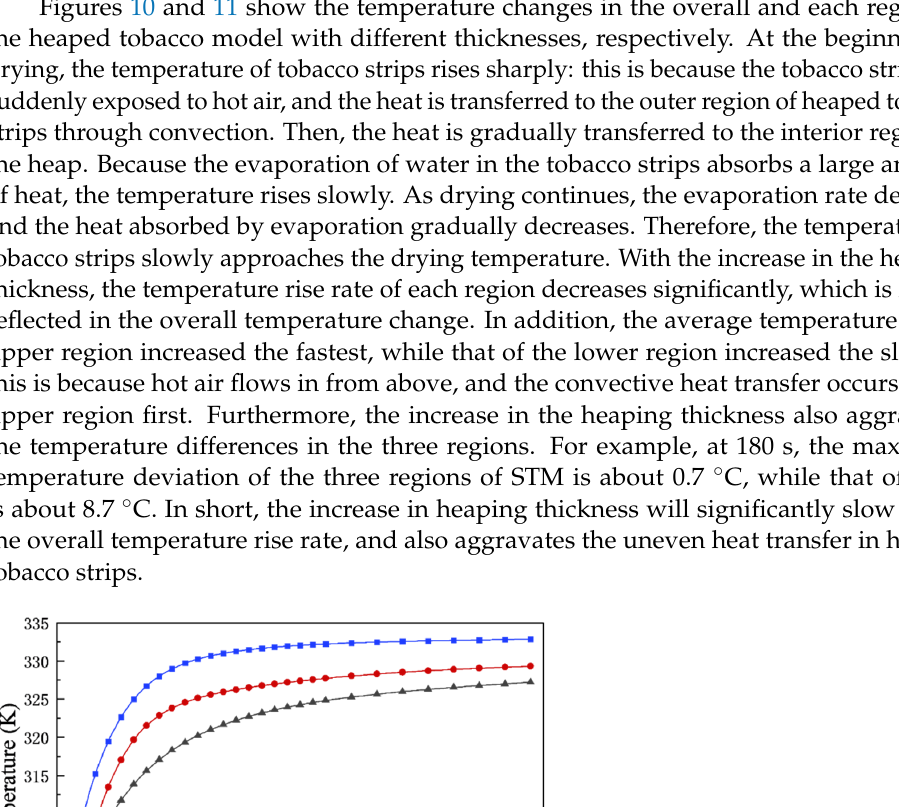
Figure 11. Average temperature in different regions of the heaped tobacco strips models. 5. Conclusions In this paper, to study the effect of heaping thickness on heat and mass transfer dur- ing convection drying of tobacco strips, a discrete heaped model of tobacco strips in the stage of tobacco redrying is established. Additionally, based on this model, a multiphase porous media model for convection drying of tobacco strips is established. The feasibility of the model is verified by experiments, and the heat and mass transfer characteristics of heaped tobacco strips during convection drying are studied comprehensively. The main conclusions are as follows: